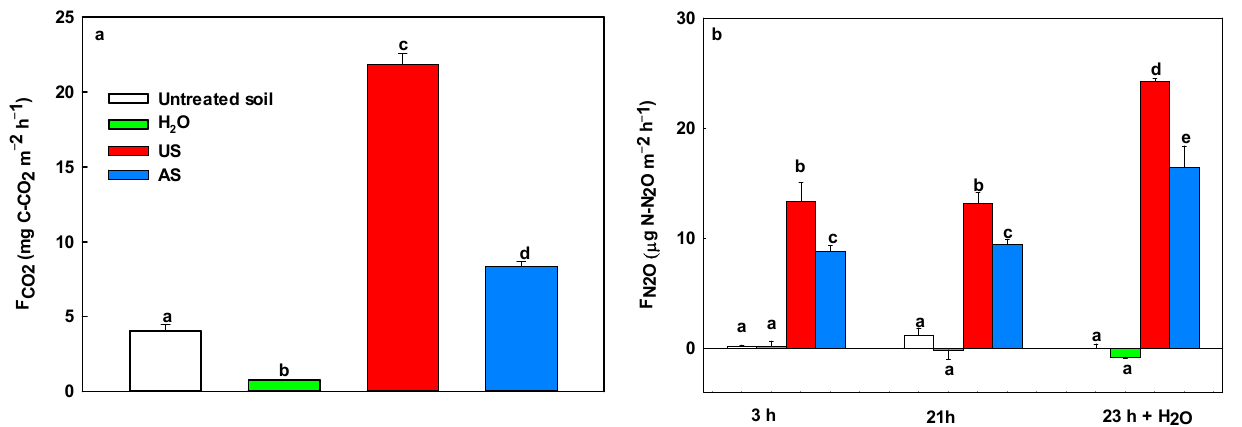
Figure 5. CO 2 ( a ) and N 2 O ( b ) fluxes in untreated soil, in soil supplied with H 2 O, and untreated (US) and pre-treated (AS) liquid fraction of slurry. Data are means ( n = 5) ± SE. Different letters denote statistically significant differences among treatments. p < 0.05.